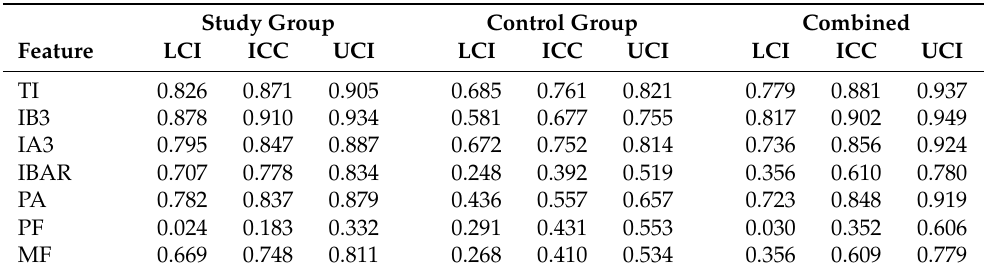
Table 1. Intraclass correlation coefficients (ICC) for each feature with corresponding 95% confidence intervals